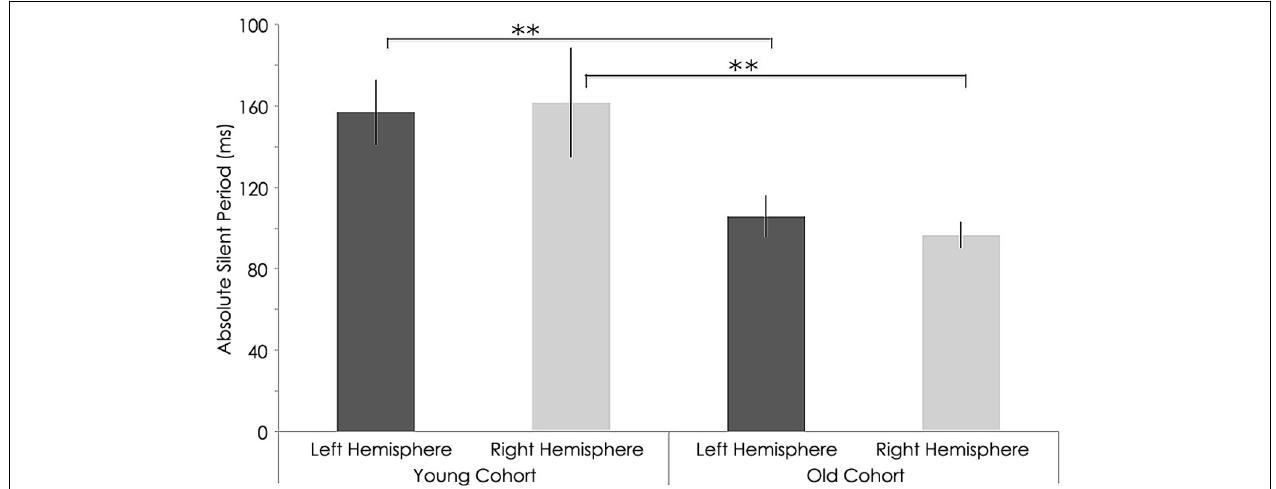
FIGURE 8 | Interhemispheric characteristics for absolute SP measure in (ms) of the study sample prior to rTMS. significant statistical differences in absolute silent period in left hemispheres among young and old subjects